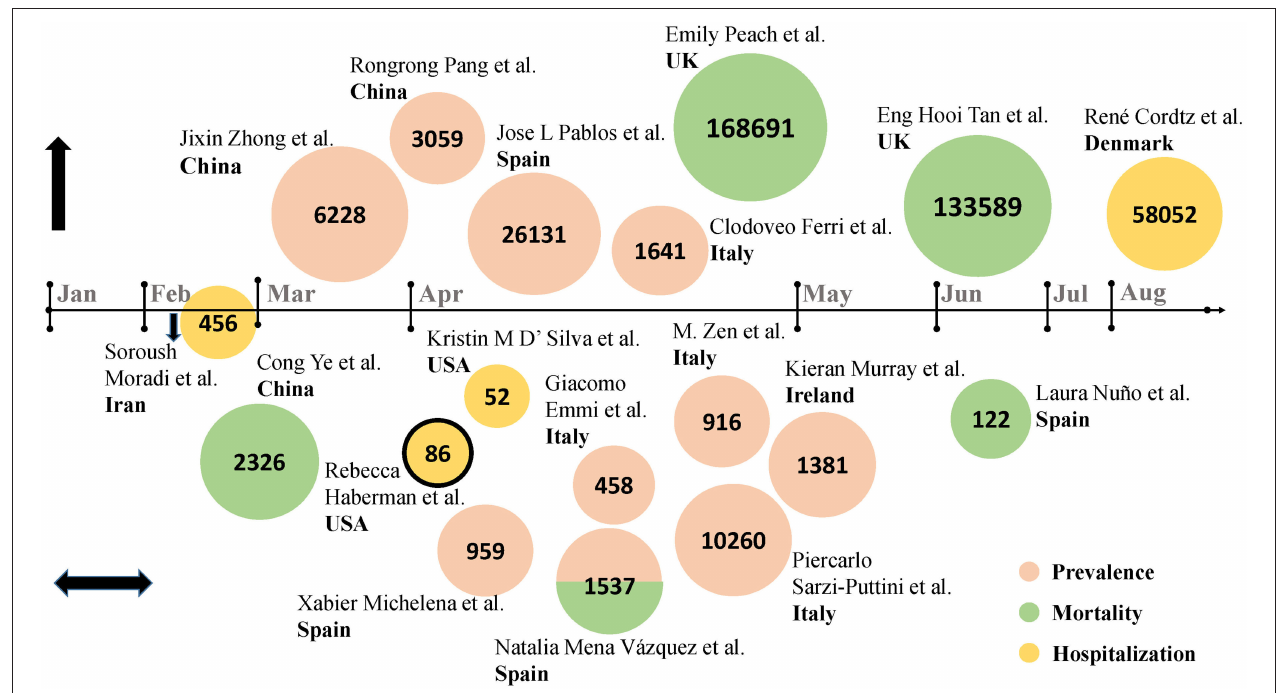
FIGURE 1 | Studies from different countries on the epidemiology of COVID-19 in RADs patients (Data from Table 1 ). Eighteen studies were included. Authors and country were detailed in the figure. The numbers in the circles represent sample size. The nodes on the horizontal axis represent the corresponding month, above the horizontal axis are studies that reported an increasing trend in indicators in RADs patients with COVID-19, below are studies that reported a similar trend in indicators, on the horizontal axis is study that reported a downward trend in indicators. Pink circles represent prevalence, green circles represent mortality, and yellow circles represent hospitalization rates. The combination of red and green indicates that the study reported both morbidity and mortality. The circle with black outline represents case series, and the rest are retrospective cohort